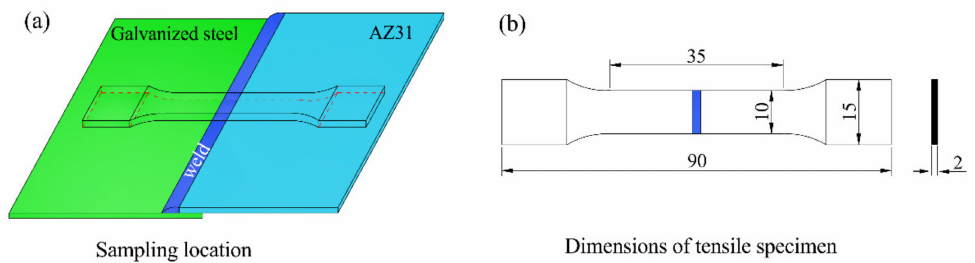
Figure 3. ( a ) The sampling point of tensile test samples and ( b ) the outline dimensions of tensile test samples